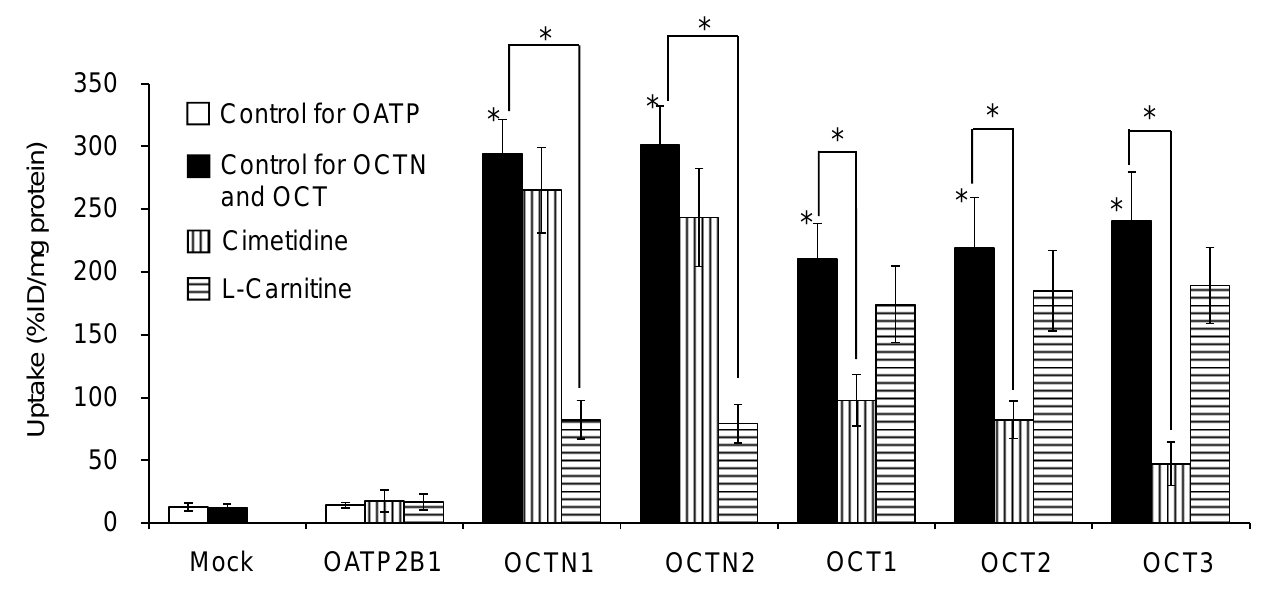
Figure 1. Uptake of [ 123 I]MIBG by human embryonic kidney (HEK)293 cells expressing a solute car- rier transporter ( n = 4). Before the experiments with [ 123 I]MIBG, the function of SLC transporters in HEK293 cells was confirmed using 3 H- or 14 C-substrates. Uptake of the 3 H-labeled substrates into HEK293 mock cells as control cells is 107.1 ± 18.5%ID/g protein for HEK-Mock cells for organic anion transporting polypeptide (OATP), 84.9 ± 22.7%ID/g protein for HEK-Mock cells for organic cat- ion/carnitine transporter (OCTN) and organic cation transporter (OCT). On the other hand, uptake of the 3 H- or 14 C-labeled substrates into HEK293 cells expressing a SLC transporter is as follows: 363 ± 38.6%ID/g protein for HEK293-OATP2B1, 387 ± 44.1%ID/g protein for HEK293-OCTN1, 379 ± 41.6%ID/g protein for HEK293-OCTN2, 403 ± 48.1%ID/g protein for HEK293-OCT1, 429 ± 58.5%ID/g protein for HEK293-OCT2, and 346 ± 37.1%ID/g protein for HEK293-OCT3. [ 123 I]MIBG uptake is significantly higher in HEK293/OCTN1, HEK293/OCTN2, HEK293/OCT1, HEK293/OCT2, and HEK293/OCT3 cells than in mock cells. Cimetidine inhibits HEK293/OCT1, HEK293/OCT2, and HEK293/OCT3, and L-carnitine inhibits HEK293/OCTN1 and HEK293/OCTN2. * p < 0.01 vs. mock cells and HEK293 cells loaded with both inhibitors.